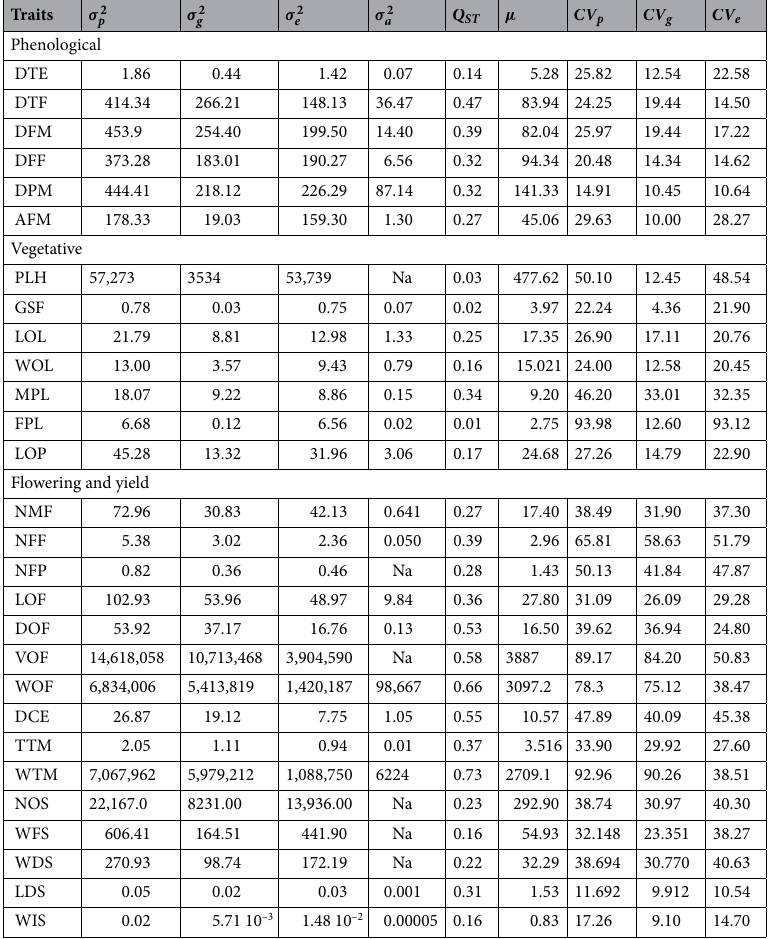
2 σ 2 σ 2 σ 2 p , g , e , a ), quantitative genetic differentiation (